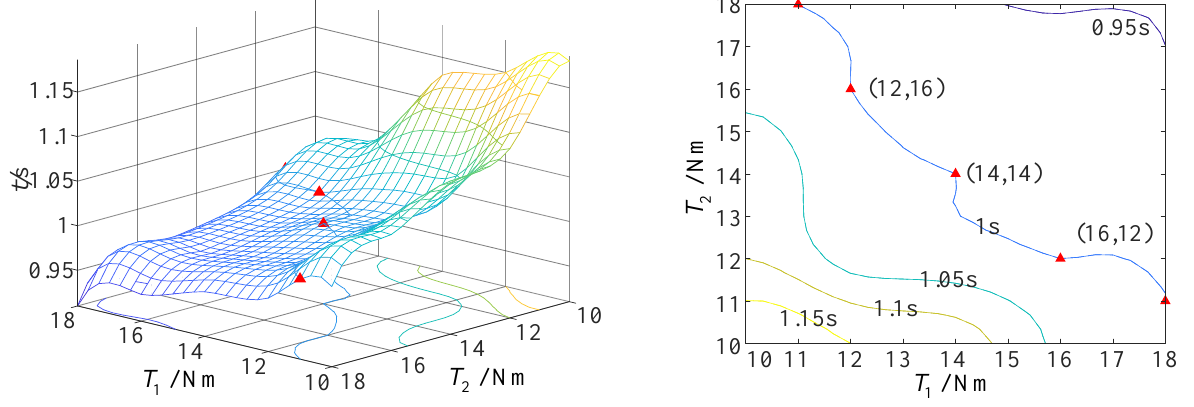
Figure 12. The curve of driving torque and deployment time of folding wing at an airspeed of 10 m/s (synchronous deployment mode).